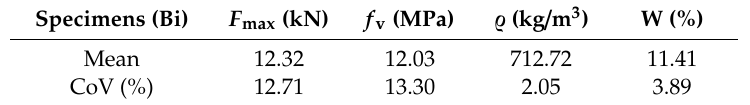
Table 4. Shear tests results obtained for the bond line evaluation using edge-bonding specimens